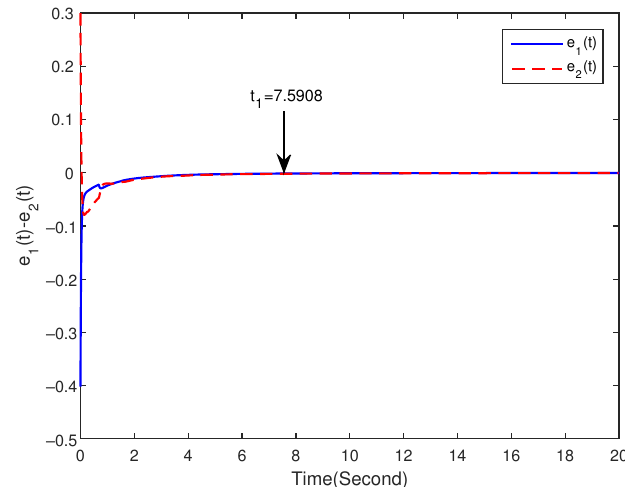
Figure 6. Trajectories of e 1 ( t ) and e 2 ( t ) with